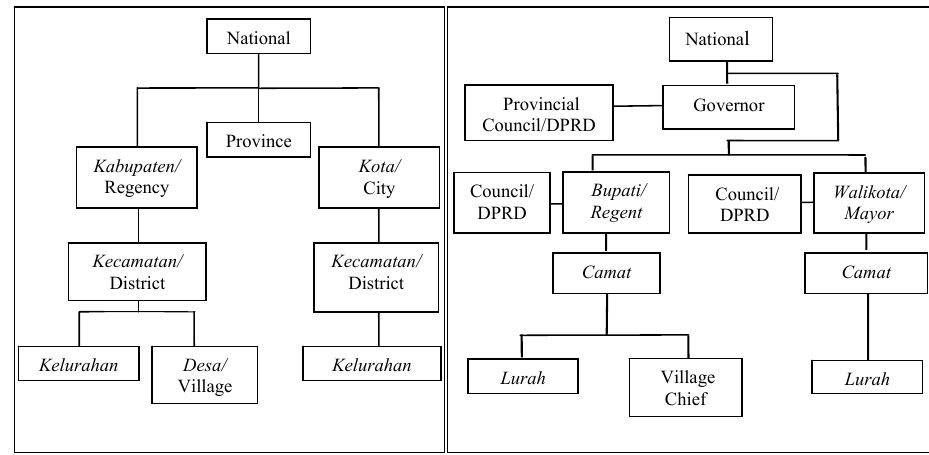
Figure 2. Functional Hierarchy